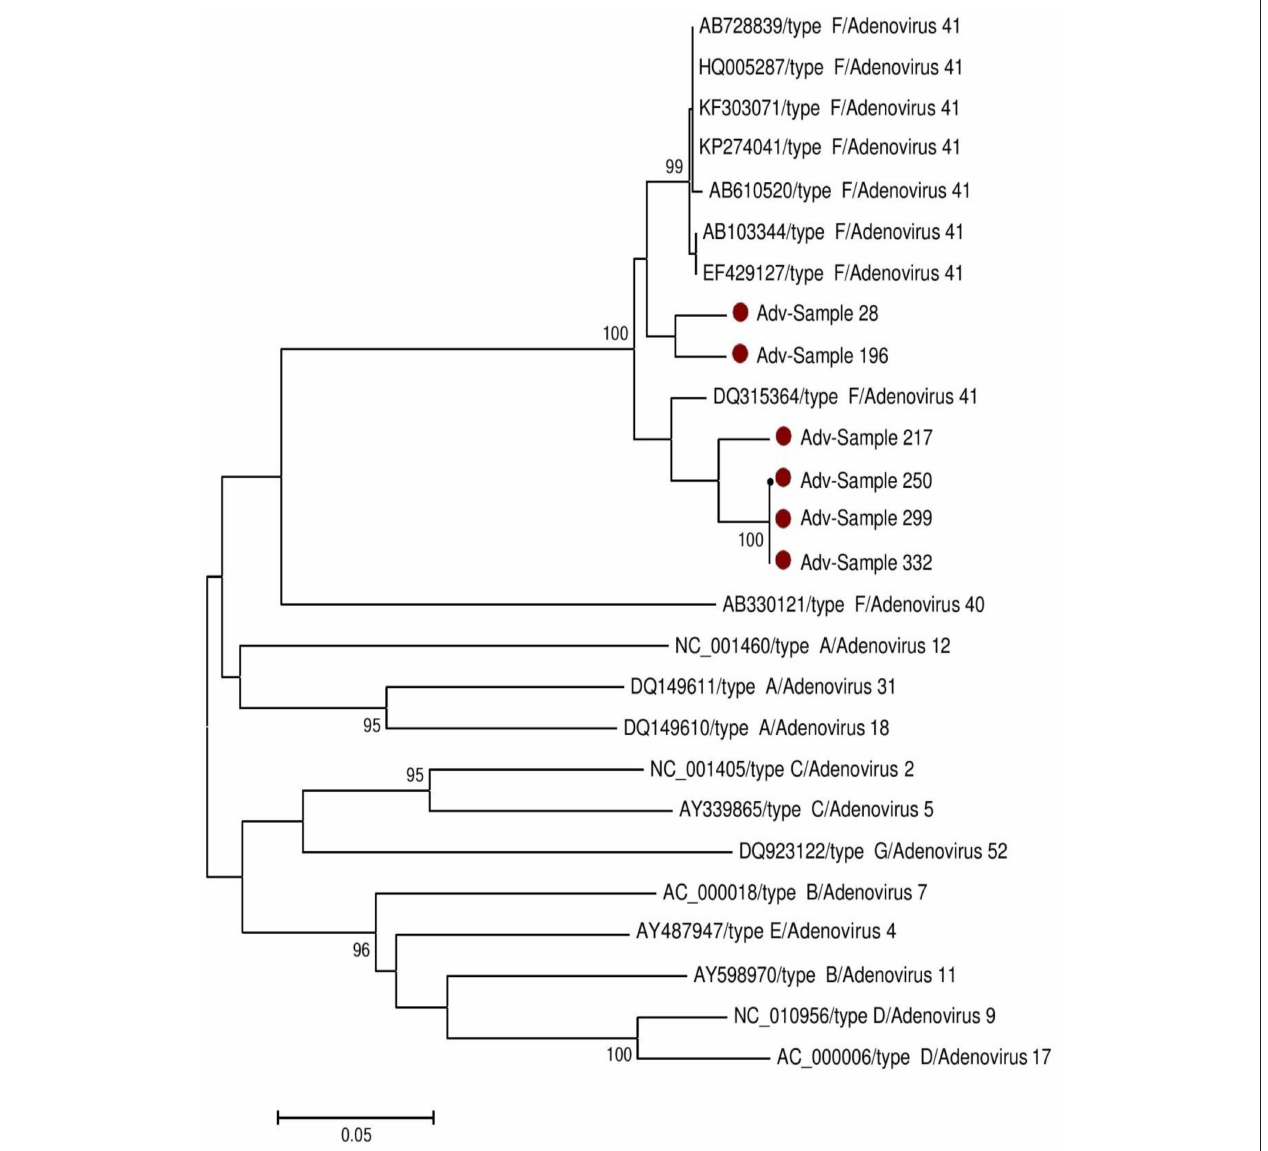
FIGURE 2 | Phylogenetic analysis of Adenovirus sequences isolated in Sudan (28, 196, 217, 250, 299, and 323). The Hexon region was used for genotyping (see Supplementary Data Sheet 2). The Kimura’s two-parameter model with 1,000 replications of bootstrap sampling implemented in MEGA 5 was used to analyze the data. Only Bootstrap values > 70% are indicated at nodes. Bars show distances. •represent Sudan Adenovirus isolates in this study.